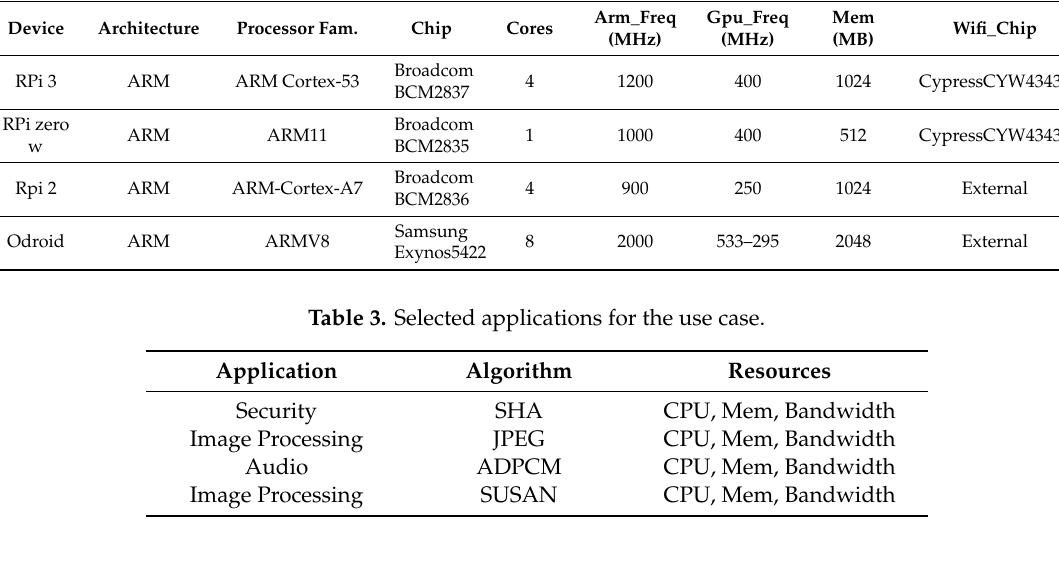
Table 2. Board information.